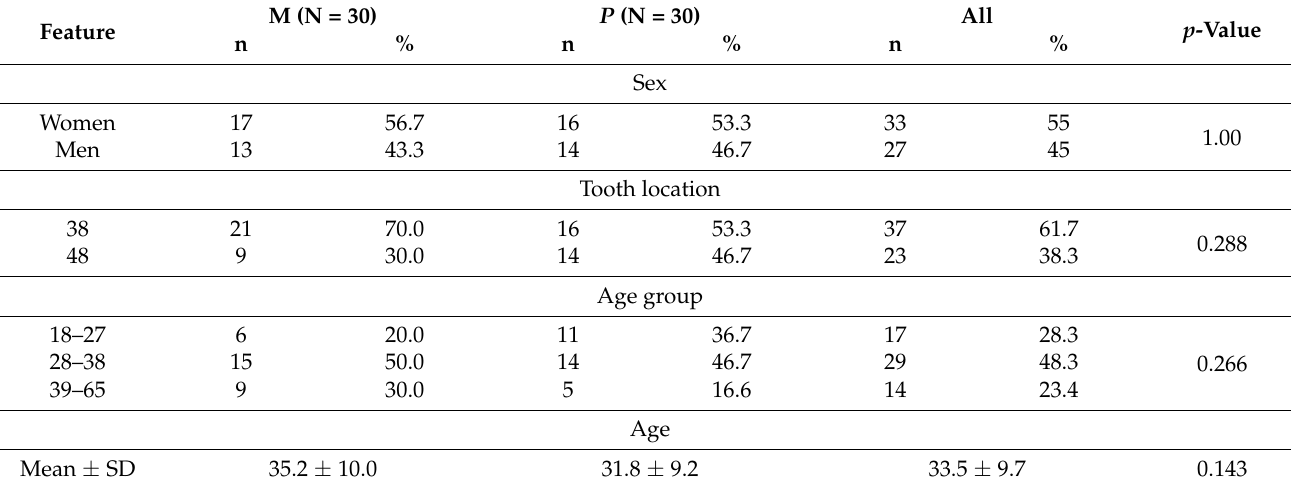
Table 2. Characteristics of patients.